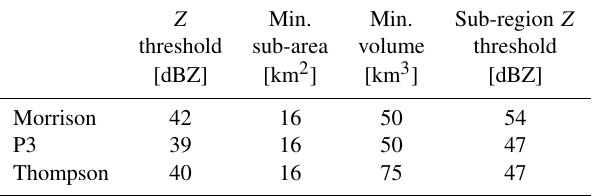
Table 3. The threshold values used in each application of TI- TAN. Other thresholds were left at default values. These thresh- olds are for the basic detection threshold ( Z threshold, the low_dbz_threshold parameter), the dual-thresholding sub- region threshold (sub-region Z threshold, dual_threshold ’s dbz_threshold parameter), the minimum allowed storm vol- ume (min. volume, the min_storm_size parameter), and the minimum area for sub-parts (min. sub-area, dual_threshold ’s min_area_each_part parameter). Z Min. Min. Sub-region Z threshold sub-area volume threshold [dBZ] [km 2 ] [km 3 ] [dBZ] Morrison